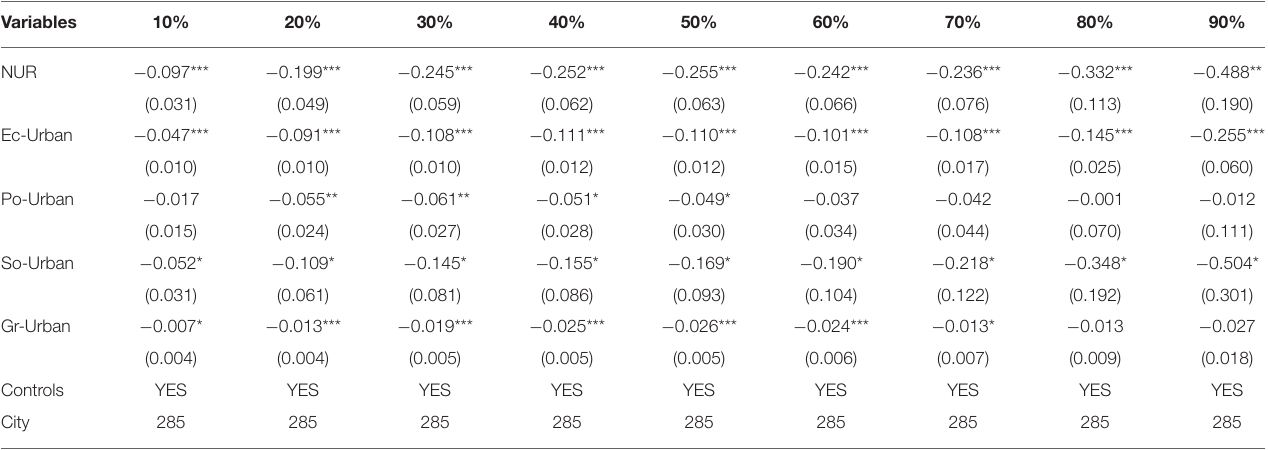
TABLE 8 | Quantile